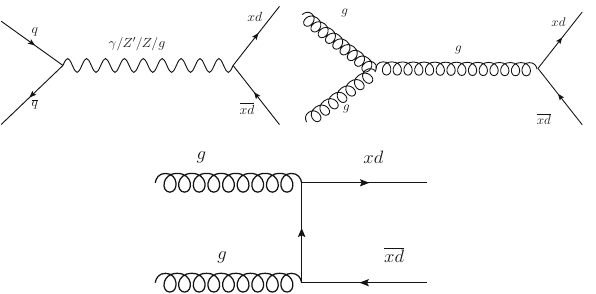
Fig. 1 The leading-order Feynman diagrams for the subprocess con- tributing to the pair production of the VLQ at the LHC